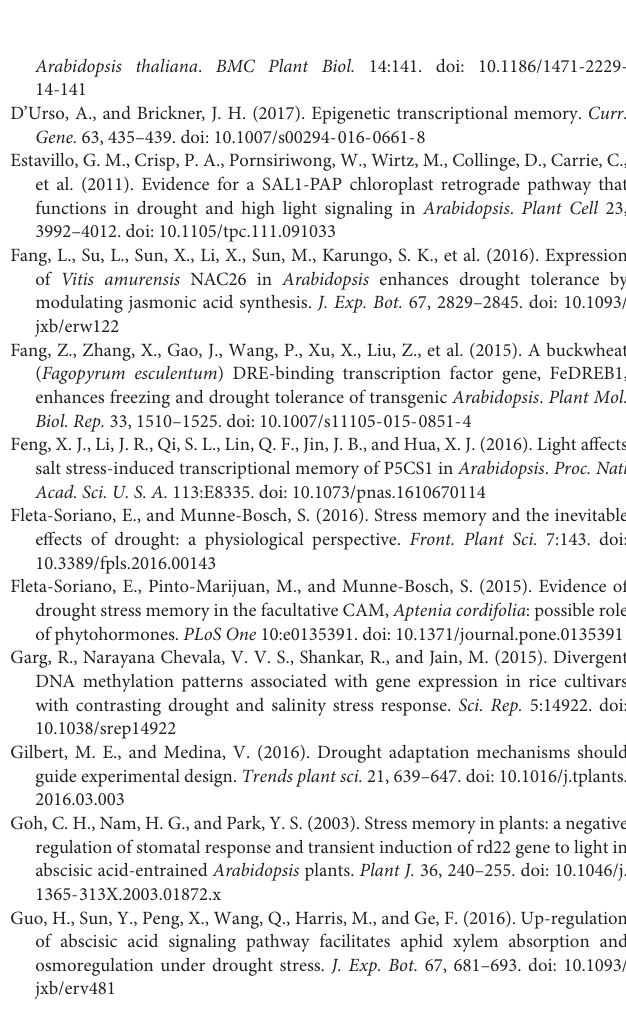
highlighted in red) and memory transcripts involved in photosynthesis. TABLE S6 | LncRNAs and mRNAs association analysis. TABLE S7 | 12 miRNAs. TABLE S8 | DNA methylation related memory transcripts. TABLE S9 | All memory